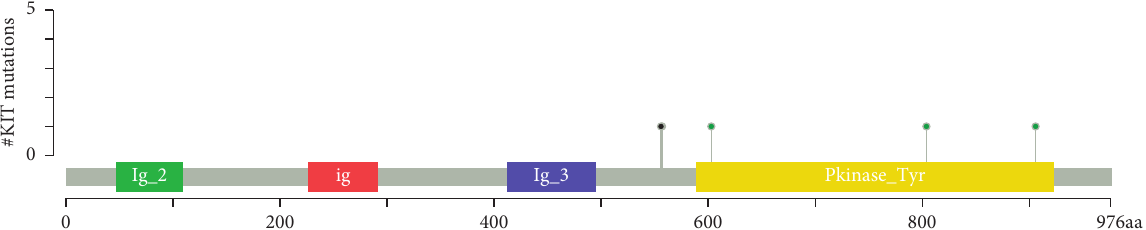
Figure 3: Schematic of KIT variants from the index patient and TCGA sarcoma database. The KIT V603D missense variant of the index patient is seen in the protein tyrosine kinase domain of the protein. The remaining four variants reported in three patients from the TCGA sarcoma database are plotted, including the frameshift variants (W557Gfs ∗ 18 and Q556Rfs ∗ 8) in a case of leiomyosarcoma, the R804Q missense variant in a separate case of leiomyosarcoma, and the C906R missense variant in a case of malignant peripheral nerve sheath